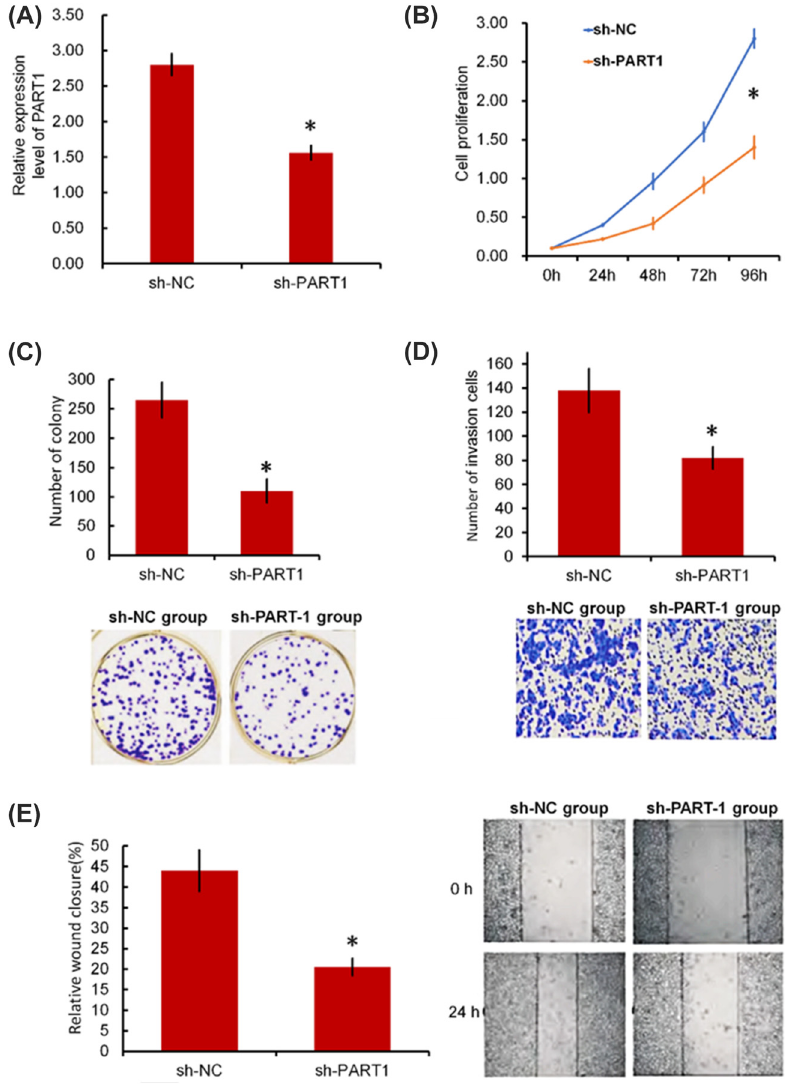
Figure 2: The e ff ect of knocking down PART-1 on the proliferation, invasion, and migration of A549 cells. (A) The expression of PART-1 in A549 cells transfectedwithPART-1shRNAsandnegativecontrolwasvalidatedbyRT ‒ qPCR.(B)Theproliferation ofsh-PART1andsh-NC cellswasdetermined bythe CCK-8assay.(C)Colonyformationofsh-PART1andsh-NCcells.(D,E)Thecellinvasionandwoundhealingresultsofsh-PART1andsh-NCcellsbyTranswell invasion assay and wound healing assay. *p<0.05 sh-PART1 group vs. sh-NC